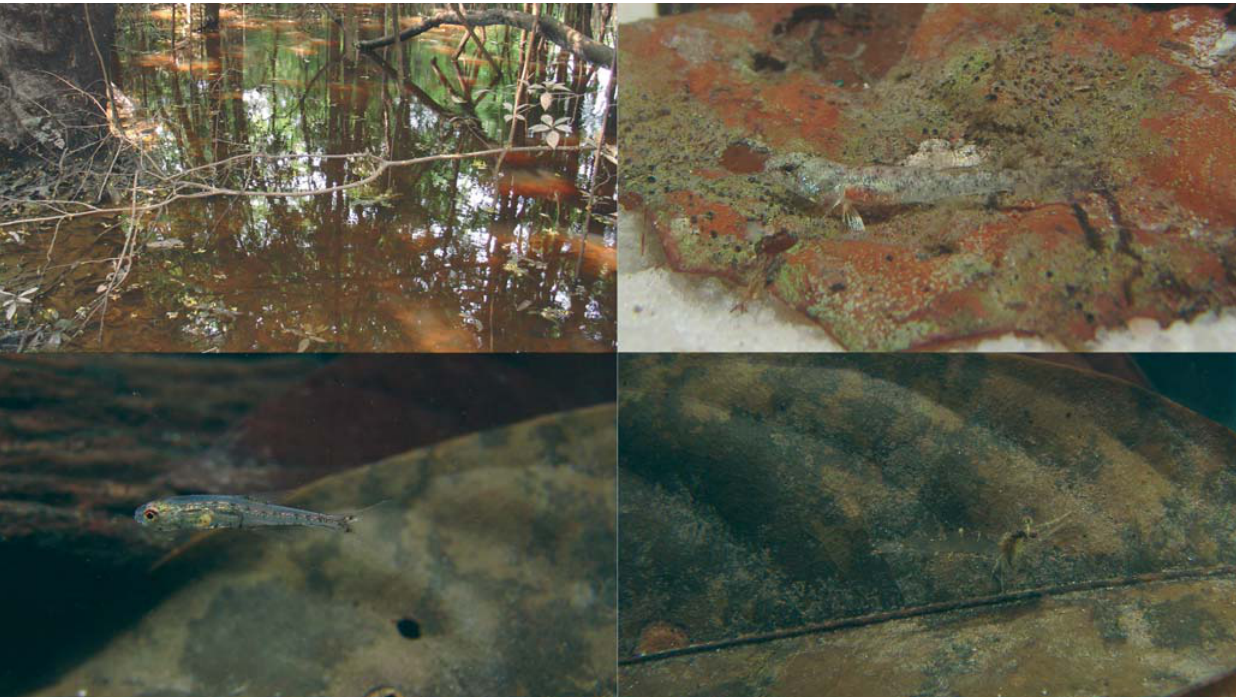
Fig. 1. The studied igapó habitat in Amazonia (top left) with leaf-litter debris on the bottom; the eleotrid fish Microphilypnus amazonicus camouflaged on a decomposing leaf (17.5 mm SL, INPA 25244, top right), the characid fish Priocharax ariel hovering in the water column close to a dead leaf (14.3 mm SL, INPA 25243, bottom left), and the palaemonid shrimp Palaemonetes carteri crawling on a dead leaf (23. 7 mm TL, INPA 1432, bottom right). The cryptic effect of each species’ colour pattern is lessened under artificial light (photographed in